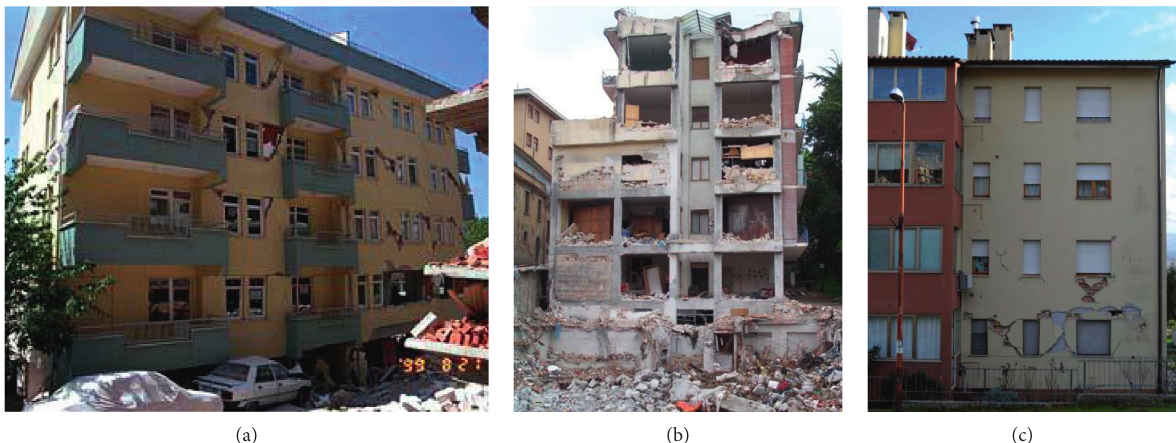
Figure 1: Example of medium-severe in-plane damage to infills (adapted from [23]). (a) Izmit (1999). (b). L’Aquila (2009). (c) Centre Italy